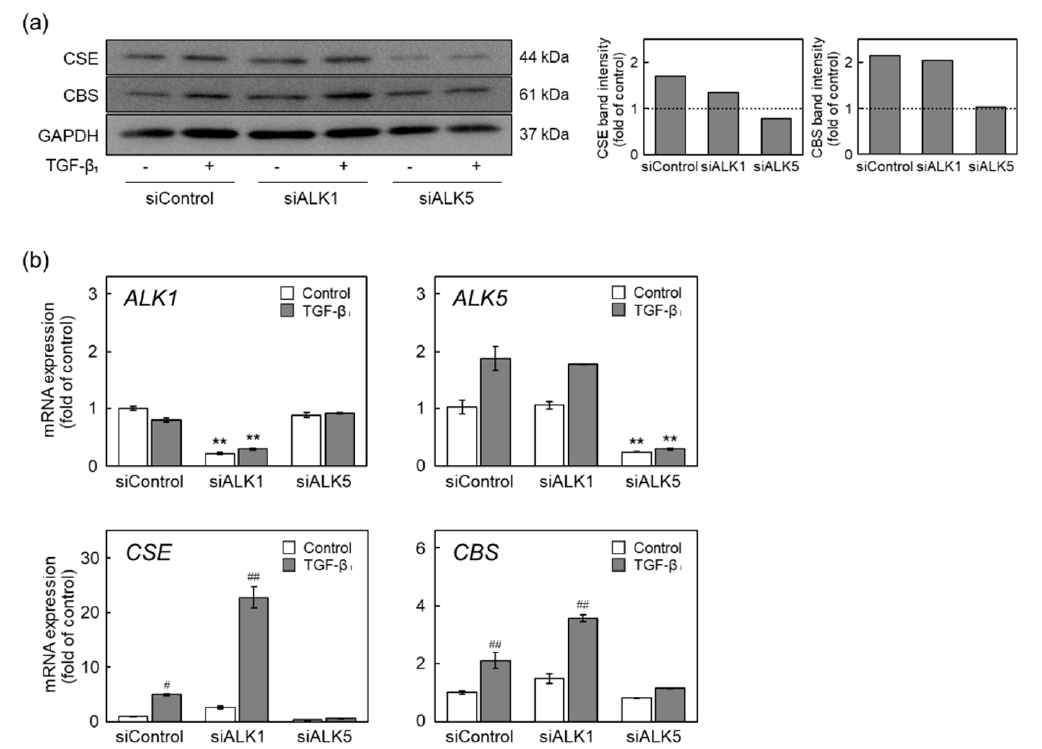
Figure 4. Involvement of ALK1 and ALK5 in the upregulation of CSE and CBS expression by TGF- β 1 in vascular endothelial cells. ( a ) Levels of CSE and CBS proteins in ALK1- or ALK5-suppressed vascular endothelial cells treated with TGF- β 1 . Subconfluent cultures of vascular endothelial cells were transfected with either ALK1 or ALK5 siRNA for 4 h and were then treated with TGF- β 1 (10 ng/mL) for 24 h. Quantification of band intensities of CSE and CBS (right panels). The data are representative of two independent experiments. ( b ) Expression of ALK1, ALK5, CSE, and CBS mRNAs in ALK1- or ALK5-suppressed vascular endothelial cells treated with TGF- β 1 . Subconfluent cultures of vascular endothelial cells were transfected with either ALK1 or ALK5 siRNA for 4 h and then treated with TGF- β 1 (10 ng/mL) for 12 h. Values are means ± S.E. of three independent samples. The data were analyzed using one-way ANOVA, followed by Tukey–Kramer’s test. ** Significantly different from the corresponding siControl, p < 0.01. Significantly different from the corresponding control, # p < 0.05; ## p <